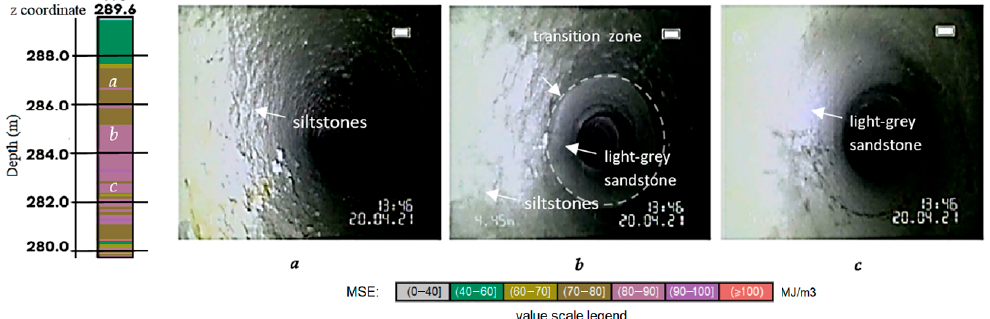
Figure 10. Video endoscopy results for borehole No. 416 of block No. N 58–70 in level +285.8 –+291.2 at Novokazansky 2 site, compared to MSE profile, where: ( a ) is the zone of prevailing siltstones; ( b ) is the zone of transition between sandstones and siltstones; ( c ) is the zone of prevailing sandstones.